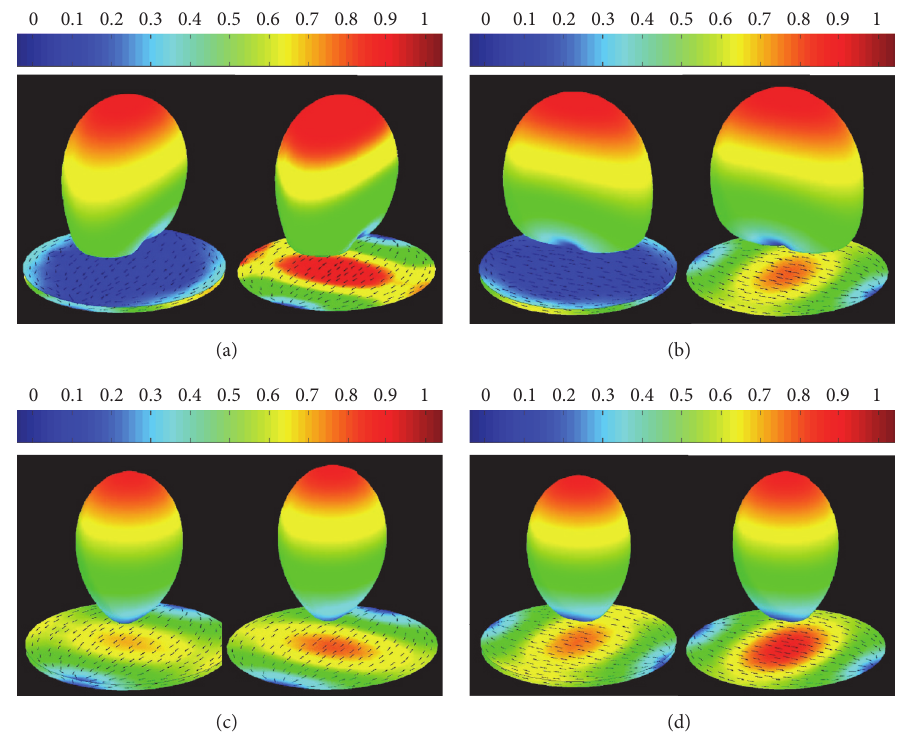
Figure 5: Characteristic currents and fields for (a) 1st mode, (b) 2nd mode, (c) 3rd mode, and (d) 4th mode. In figures (a)–(d), the left figure shows the characteristic currents on the top patch, while the right figure shows the characteristic currents on the bottom